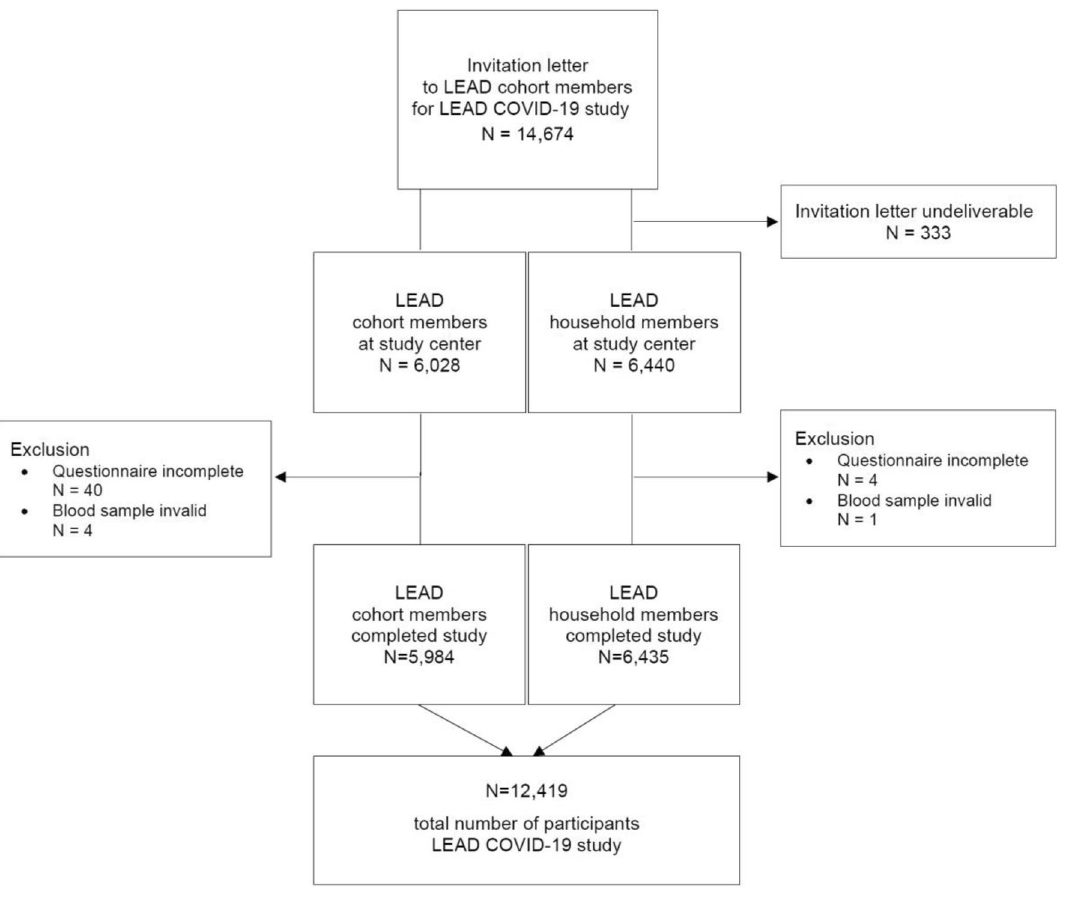
Figure 1. Flow chart of